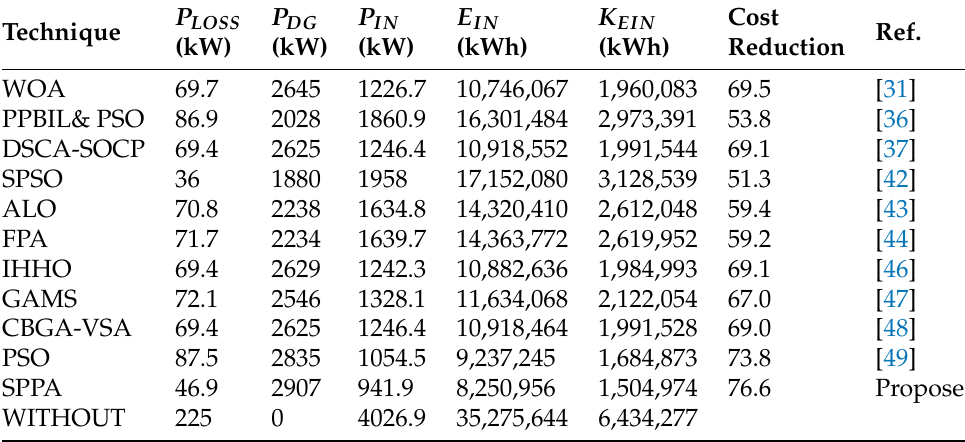
Table 4. Cost reduction comparison of